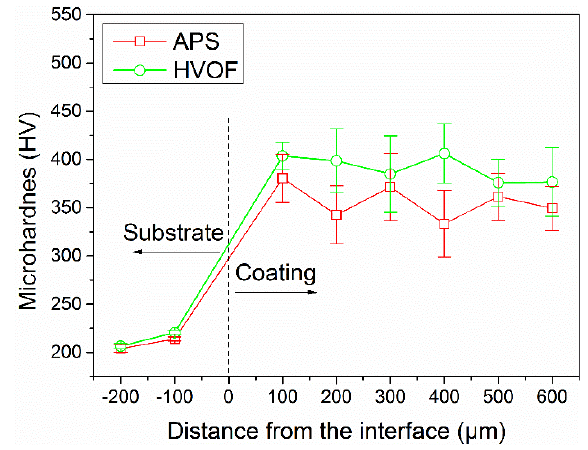
Figure 6. Microhardness profiles along the cross section of the HEA coatings.